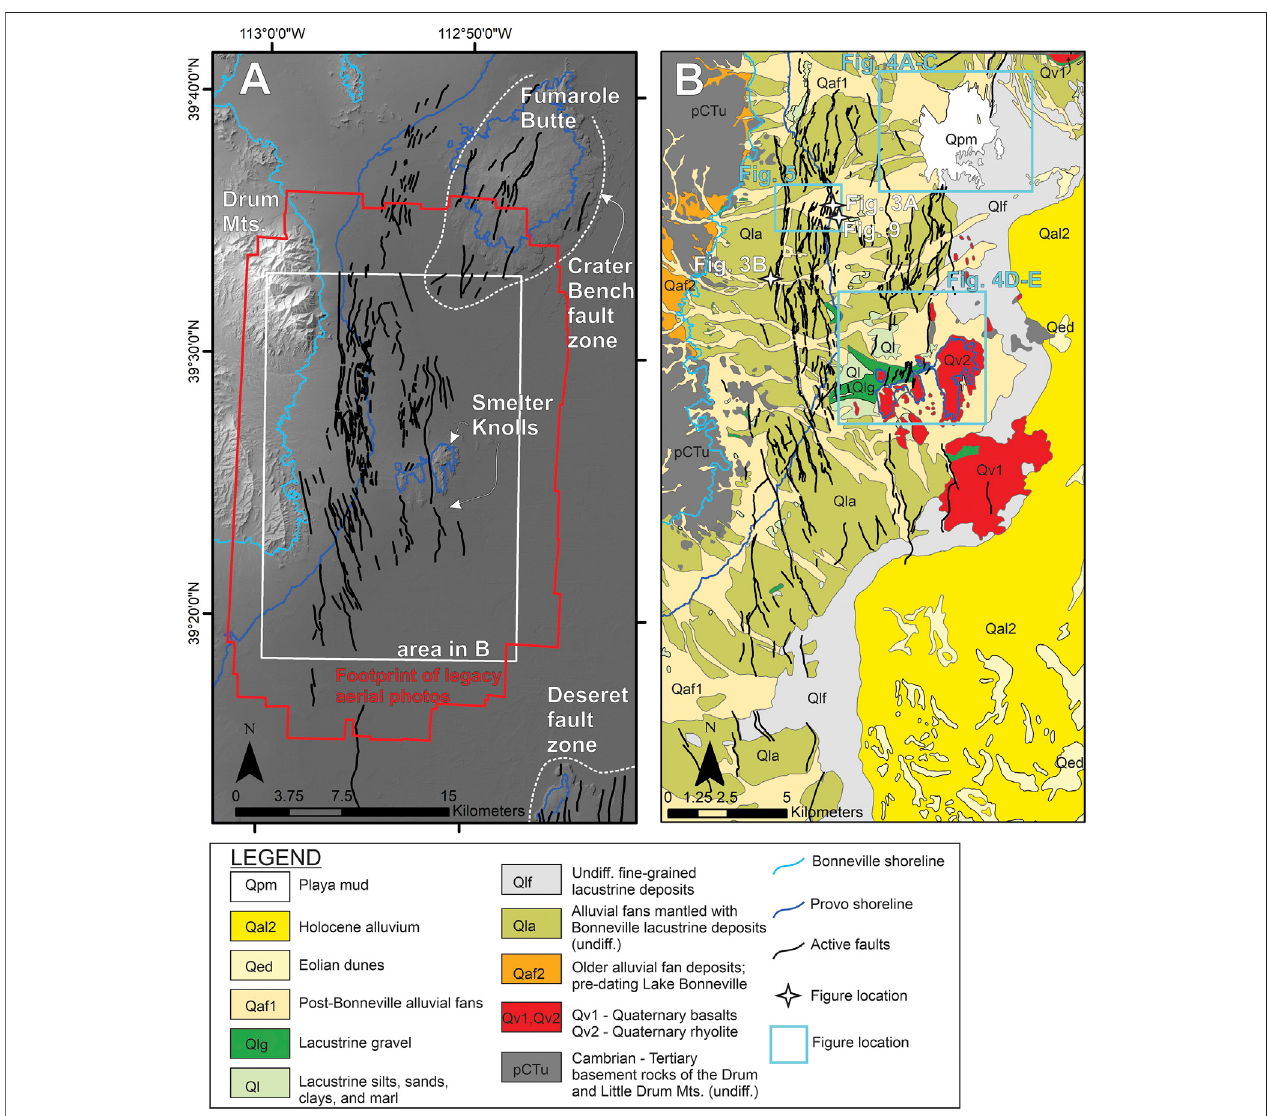
FIGURE 2 | Maps of the Drum Mountains fault zone and surrounding faults. (A) Hillshaded elevation model with Quaternary faults as mapped in the USGS Quaternary Fault and Fold database (USGS, 2020) and the reconstructed elevations of the Bonneville and Provo shorelines (note, these do not necessarily represent locations of landforms). The footprint of the legacy aerial photographs used in this study is shown in red. (B) Simpli fi ed geologic map (modi fi ed after Hintze and Davis, 2002) of the primary study area with fault traces mapped in this study. The locations of subsequent fi gures are shown in outlines and stars.